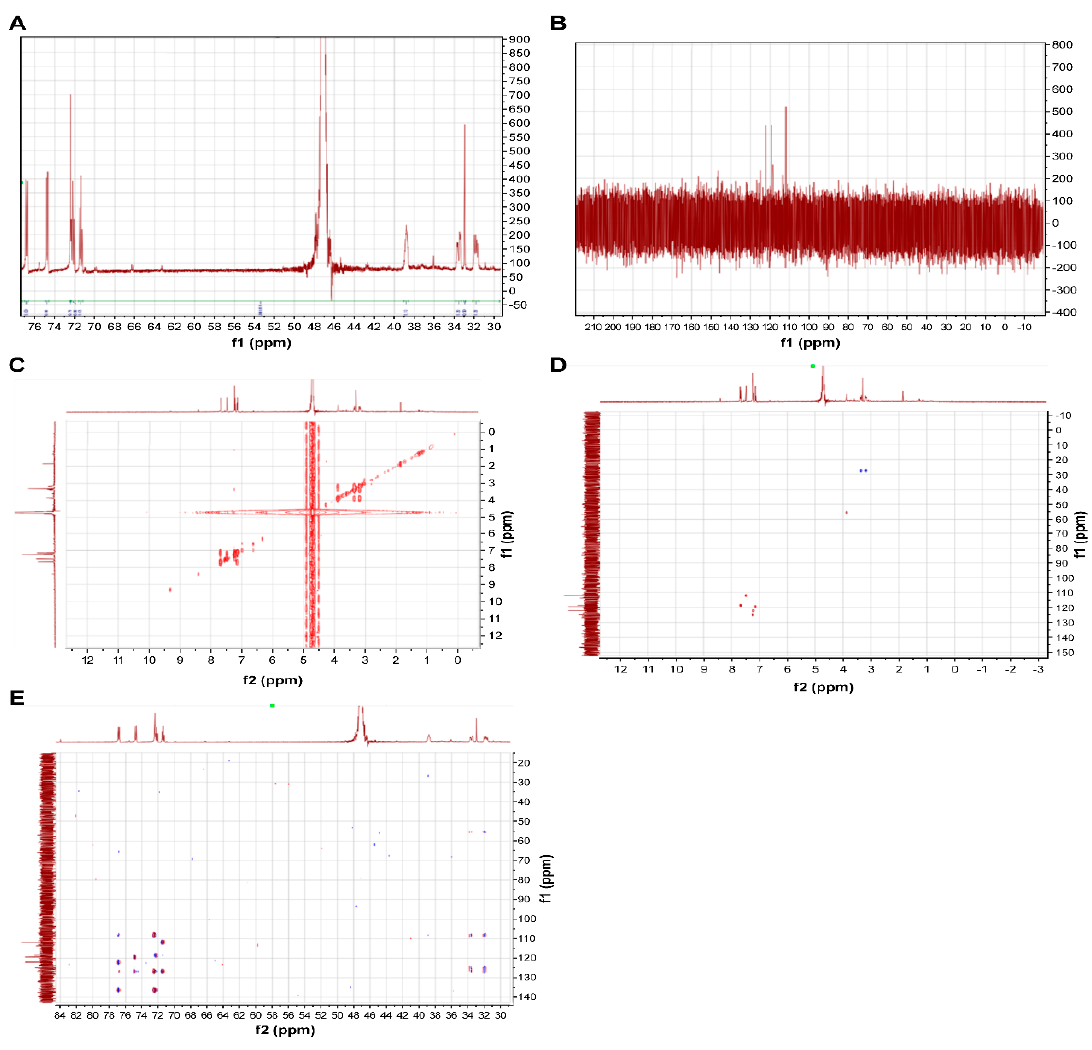
Figure 4. Mass spectroscopy spectrum of D-tryptophan (Trp).